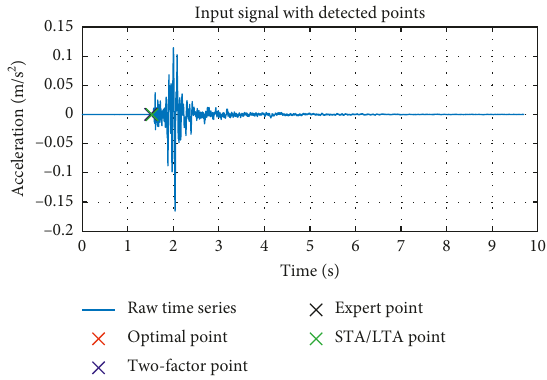
Figure 5: First three principal components. Significance values are 87%, 4% , and 2% , respectively.